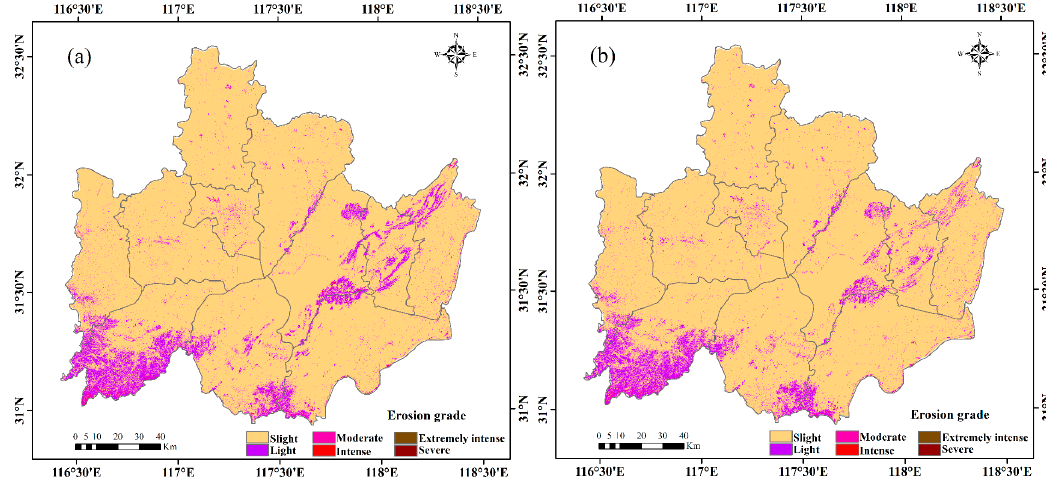
Figure 7. Soil erosion grading maps of the CLB: ( a ) soil erosion modulus estimated from Equation (1); and ( b ) soil erosion modulus estimated from Equation (15).